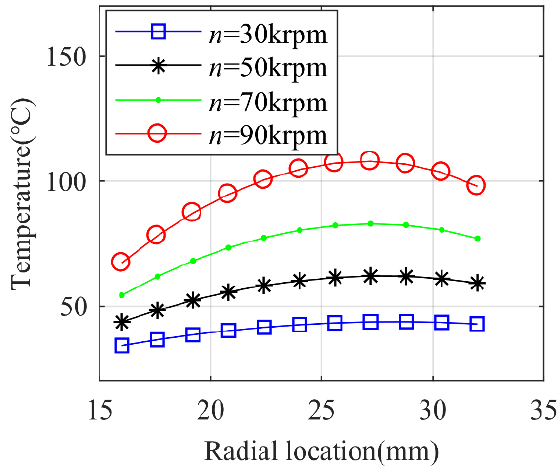
Figure 14. Relationship between thrust plate temperature and speed.